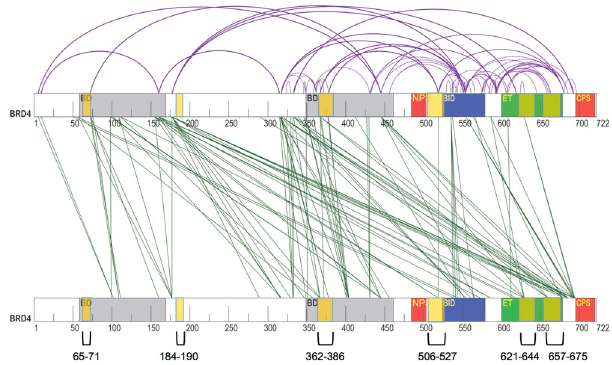
Fig. 3 XL-MS analysis provides insight into the overall topology of the BRD4 dimer. Graphical representation of the cross-link (XL)-MS